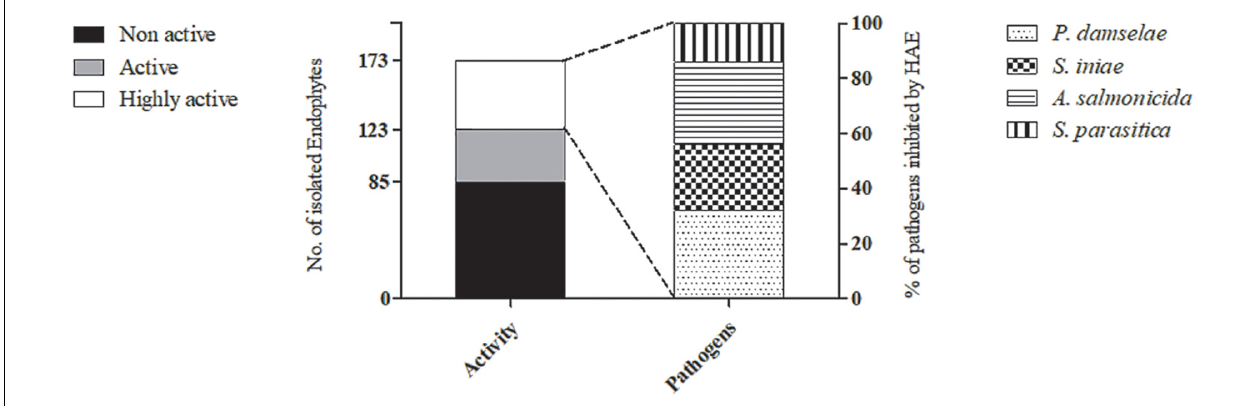
FIGURE 2 | Bioactivity of the endophytes isolated from different algae. The number of endophytes isolated from the 20 different algae, classified by bioactivity level, is demonstrated (primary Y -axis). The highly active endophytes (HAE) are featured by their activity against each of the four pathogens (secondary Y -axis).